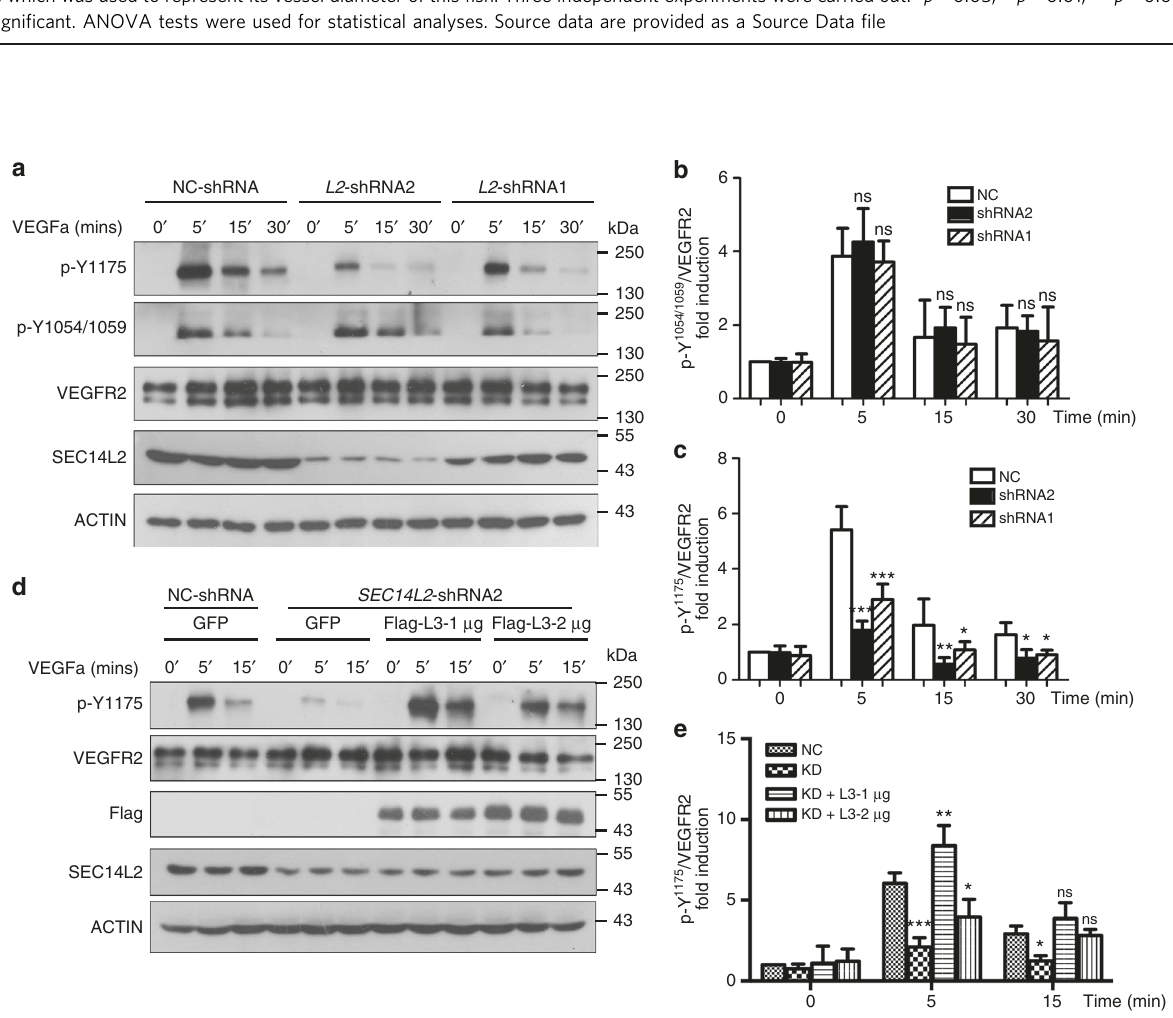
Fig. 4 SEC14L2 knockdown decreased VEGFR2 phosphorylation at Y 1175 site. a Western blot analysis of cell lysates from NC or SEC14L2 shRNA infected HUVECs. Cells were infected and starved overnight, followed by 100 ng ml -1 VEGFa stimulation for 5, 15 or 30 min, respectively. VEGFR2 (p-Y 1175 ), VEGFR2 (p-Y 1054/1059 ), and total VEGFR2 levels were examined by immunoblotting using respective antibodies. b , c Statistical results of p-VEGFR2-Y 1054/ 1059 ( b ) and p-VEGFR2-Y 1175 ( c ) levels in a relative to total VEGFR2. Data are normalized to control group without stimulation and shown as mean ± SEM from three independent experiments. * p < 0.05; ** p < 0.01; *** p < 0.001; ns, not signi fi cant. d , e Overexpression of zebra fi sh sec14l3 in HEK293T cells restores the level of p-VEGFR2-Y 1175 inhibited by SEC14L2 knockdown. One or two micrograms sec14l3 plasmid was transfected into SEC14L2 knockdown stable HEK293T cells with VEGFR2 overexpression. Following starvation overnight, 100 ng ml -1 VEGFa was added and stimulation continues for 0, 5 or 15 min. Quanti fi cation data of the relative p-VEGFR2-Y 1175 level from three repeated experiments are normalized to control group with 0 ’ stimulation and shown on the right ( e ). * p < 0.05; ** p < 0.01; *** p < 0.001; ns, not signi fi cant. The loading volume of a , d was adjusted for the same amount of total VEGFR2 level in each lane. Two-way ANOVA tests were used for statistical analyses in b , c , and e . Source data are provided as a Source Data fi